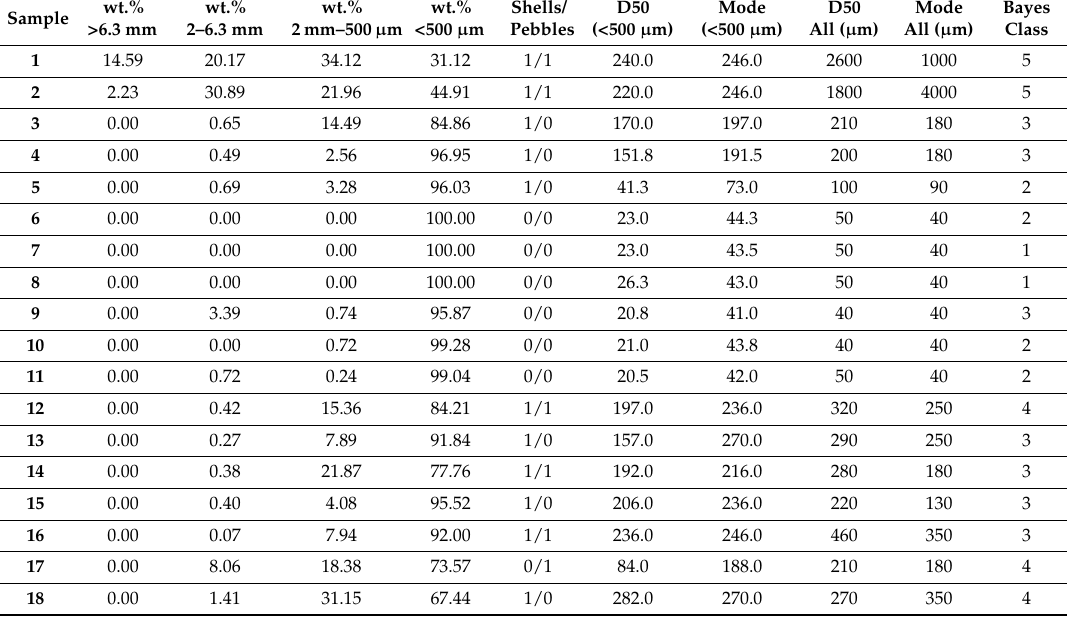
Table 1. Grain size analysis data and Bayes class [3] for sediment samples 1–18 shown in Figure 2a. Green cells indicate the five samples used for deriving the different angular responses in Figure 4.